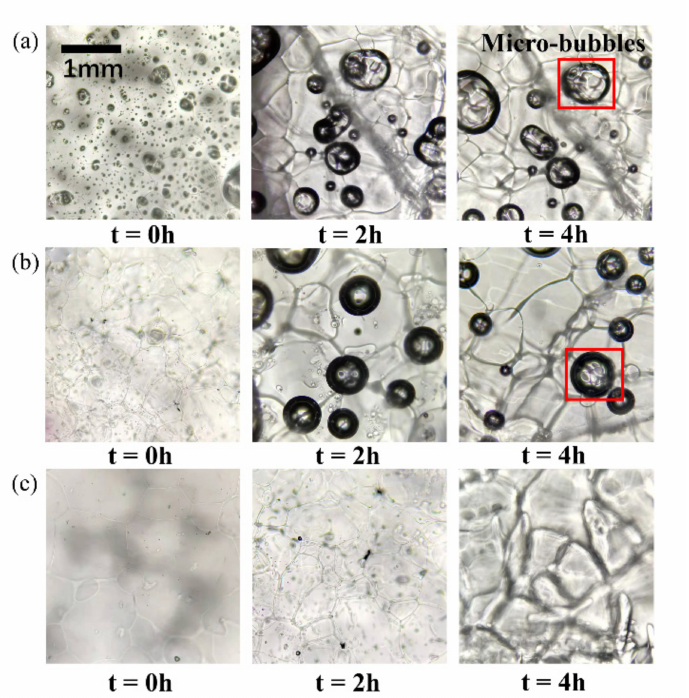
Figure 9. Optical microscope images of the ozone ice surface during melting: ( a ) 600 mg/L;